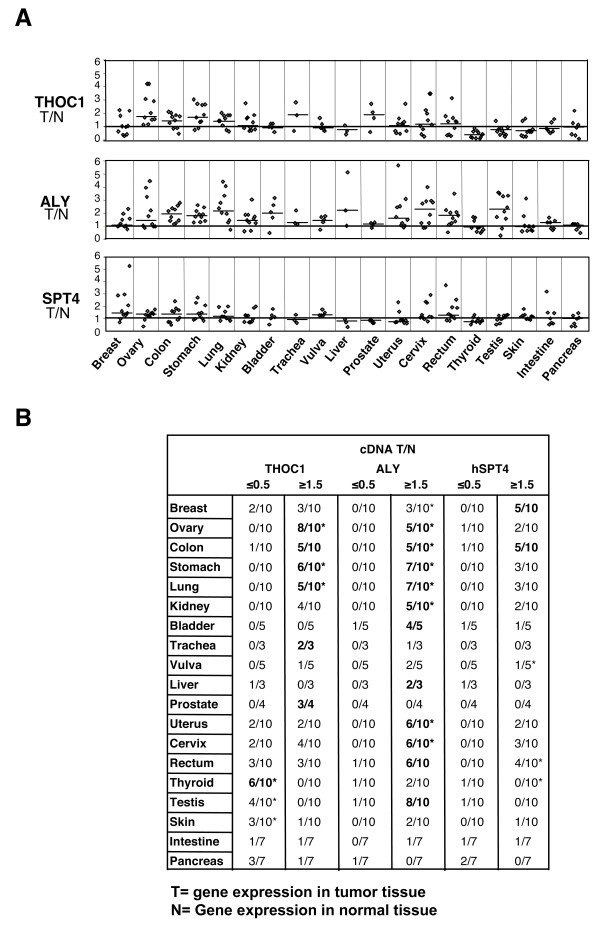
THOC1, ALY and hSPT4 expression in paired normal/tumor tissues by cDNA array. (A) A Cancer Profiling Array II (Clontech), representing cDNA pools from matched tumor and normal tissue, was hybridized with specific [32P]dCTP-labeled THOC1, ALY and hSPT4 probes, according to manufacturer's instructions. cDNA expression values were calculated by quantification of signal intensities in a FUJI FLA 3000. Gene expression in paired tumor/normal tissues from the same patient was quantified considering expression in normal tissues as one unit. Upper panel represents the ratio tumor/normal of each pair in the different types of tumors. N, normal; T, tumor. (B) Number of tumors showing upregulation (T/N > 1.5) or downregulation (T/N < 0.5) of THOC1, ALY and hSPT4 genes. The number is marked in bold in that tissues where the genes were up- or down-regulated in ≥50% of the tumors analyzed. A two-tailed paired t-test was used to determine whether the differences in cDNA levels in tumor versus normal samples were statistically significant (marked with *, for details see Additional file 3).